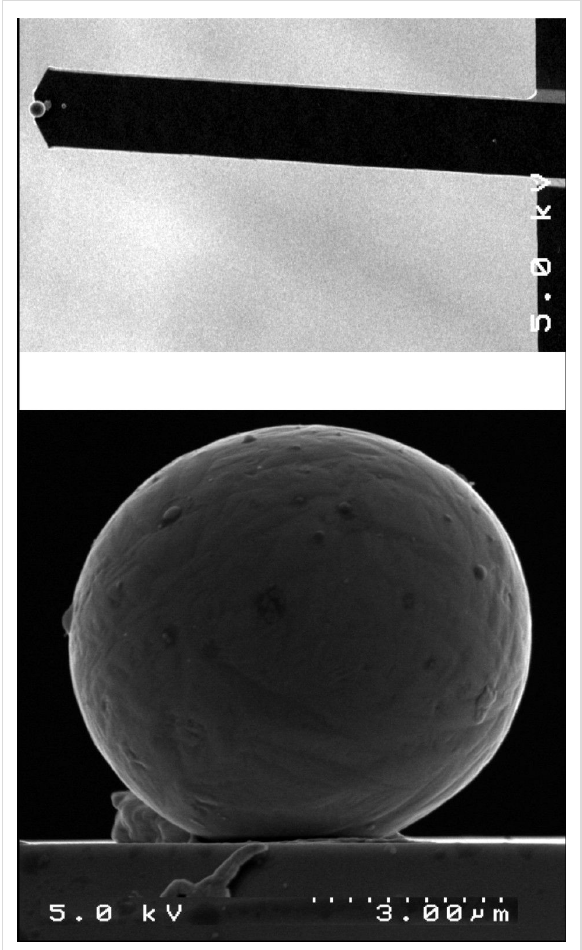
Figure 6: SEM images of a Ti microsphere (diameter 7.2 µm) at- tached at the free end of a single beam tipless AFM